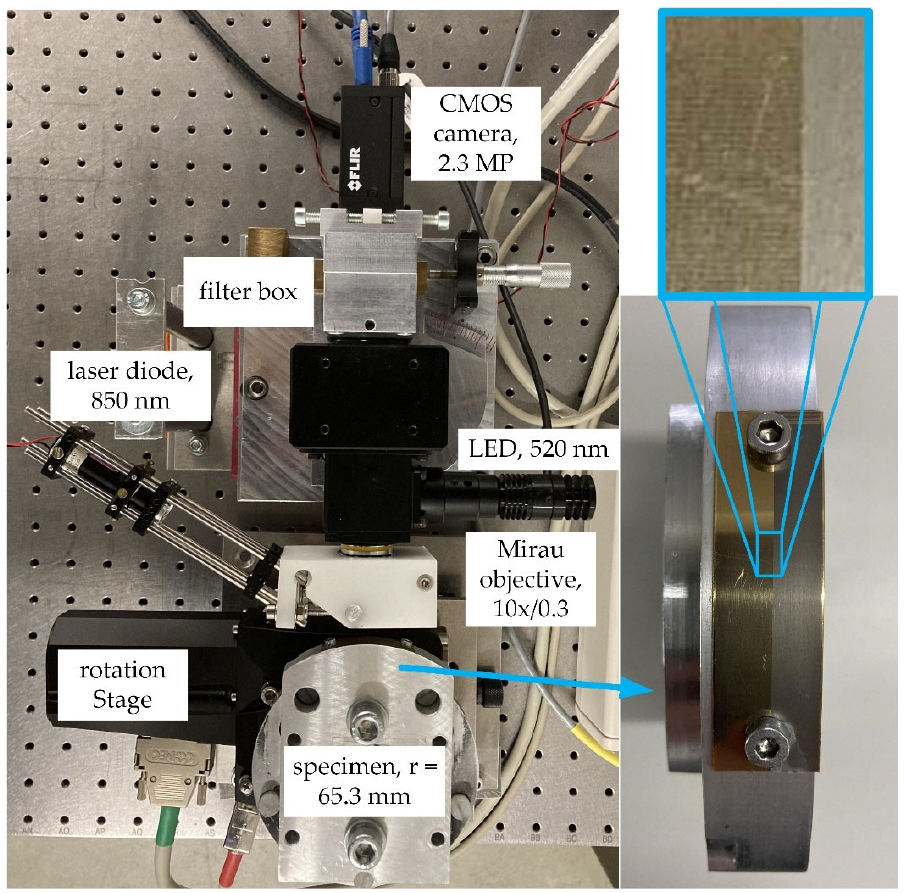
Figure 4. Experimental setup and measurement object. Left: Experimental setup for rotatory LSWLI. Right: Face view of the measurement object: linear encoder strip spanned on a milled base resulting in a 65.3 mm surface radius.